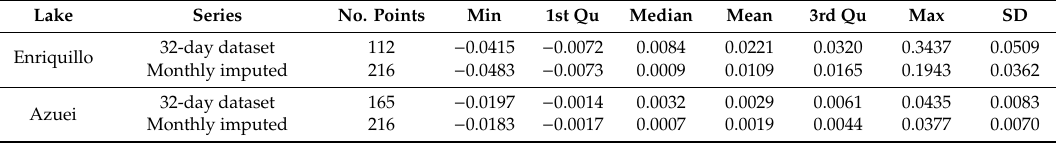
Table 2. Statistical variables of the lakes volume change